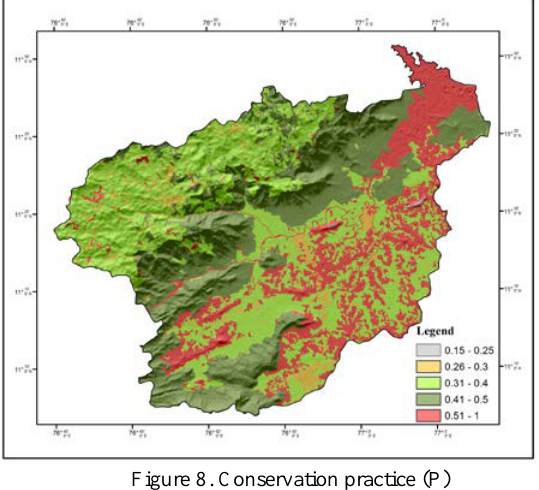
Figure 8. Conservation practice